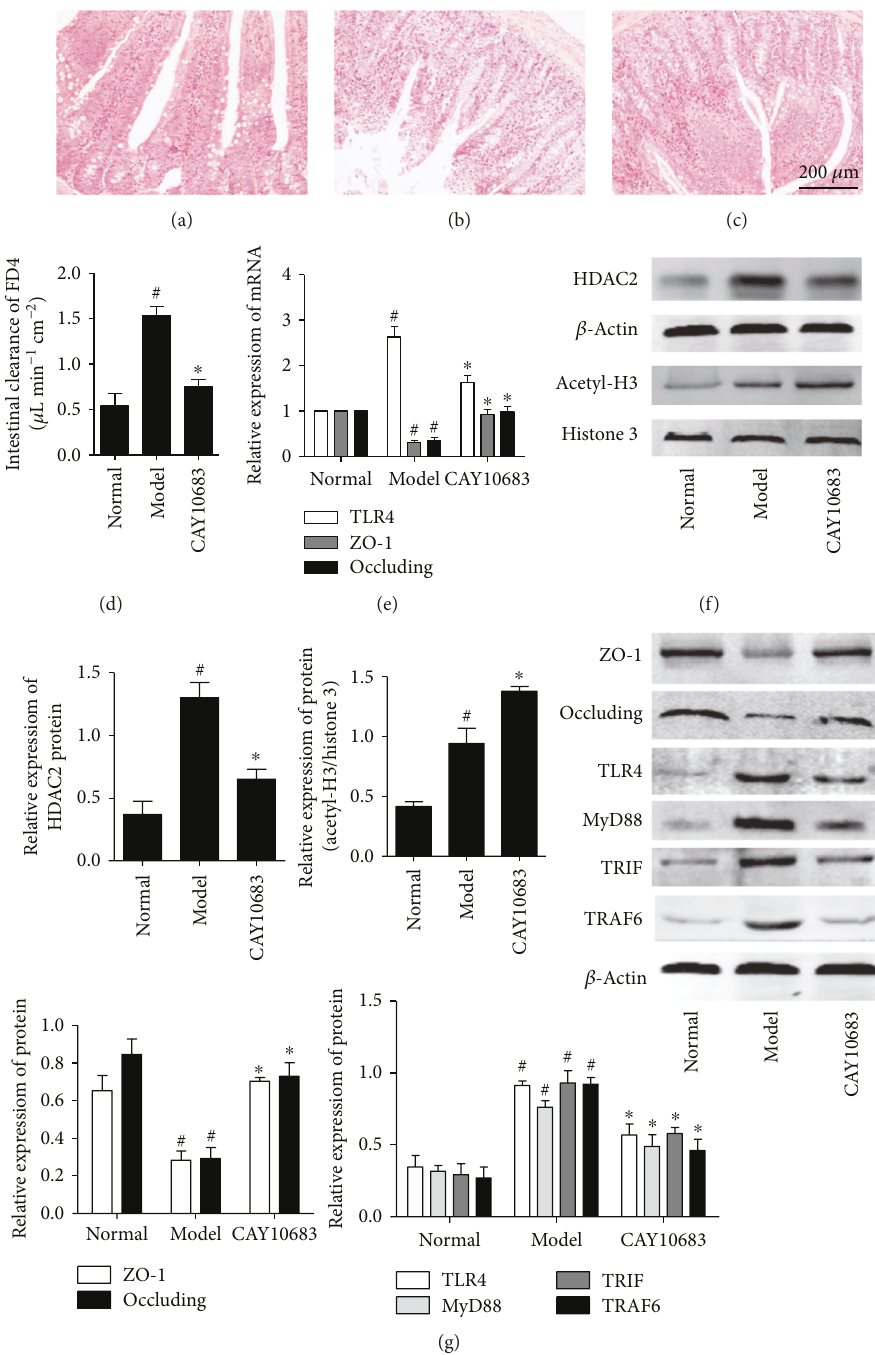
Figure 5: (a – c) E ff ect of CAY10683 on small intestine damages in ALF rats: (a) normal group, (b) model group, and (c) CAY10683 group. (d) E ff ect of CAY10683 on the intestinal permeability in ALF rats. (e) E ff ect of CAY10683 on the mRNA expression of TLR4, ZO-1, and occludin in ALF rats. (f) E ff ect of CAY10683 on HDAC2 and acetyl-H3 in ALF rats. (g) E ff ect of CAY10683 on the protein levels of ZO-1, occludin, TLR4, MyD88, TRIF, and TRAF6 protein levels in ALF rats. Values are expressed as mean ± SD. # P < 0 05 , compared with normal group; ∗ P < 0 05 , compared with model